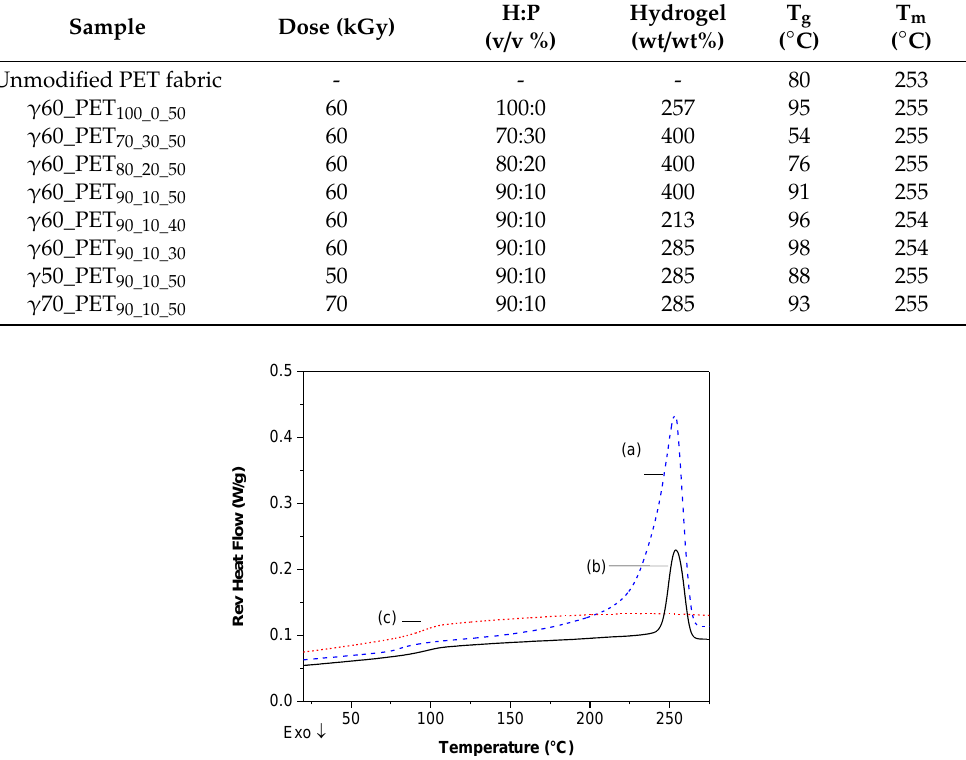
Figure 5. DSC curves of ( a ) PET, ( b ) γ60 PET 90:10:30 400% hydrogel, and ( c ) γ60 poly(HEMA -co- PEGMA) hydrogel.